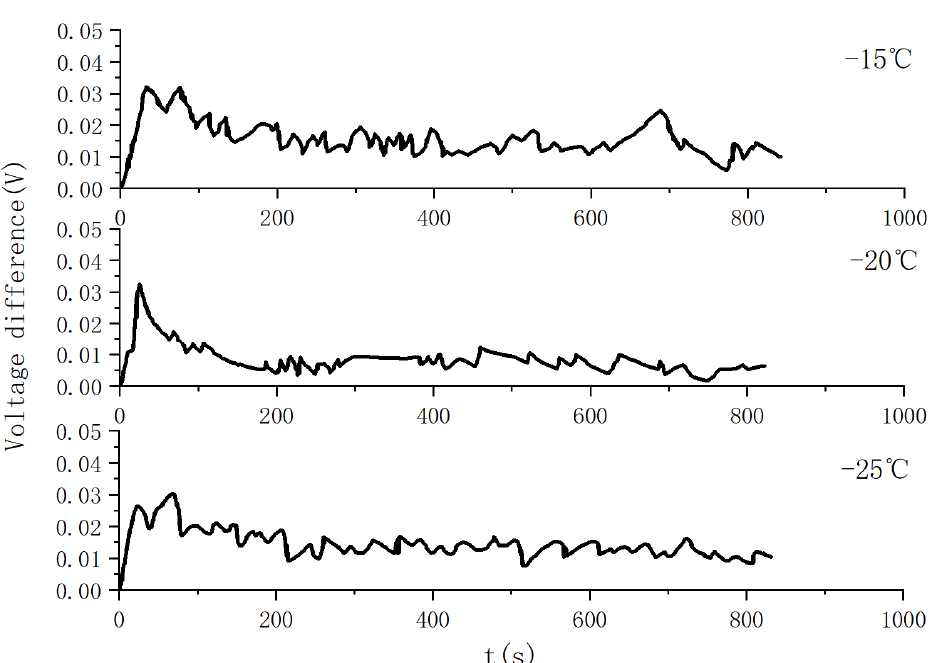
Figure 7. Graphs of the voltage difference change in Stack B with time.